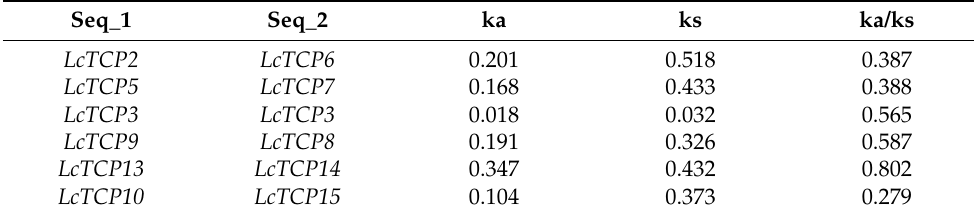
Table 2. Ka/Ks ratio between L. chinense homologous